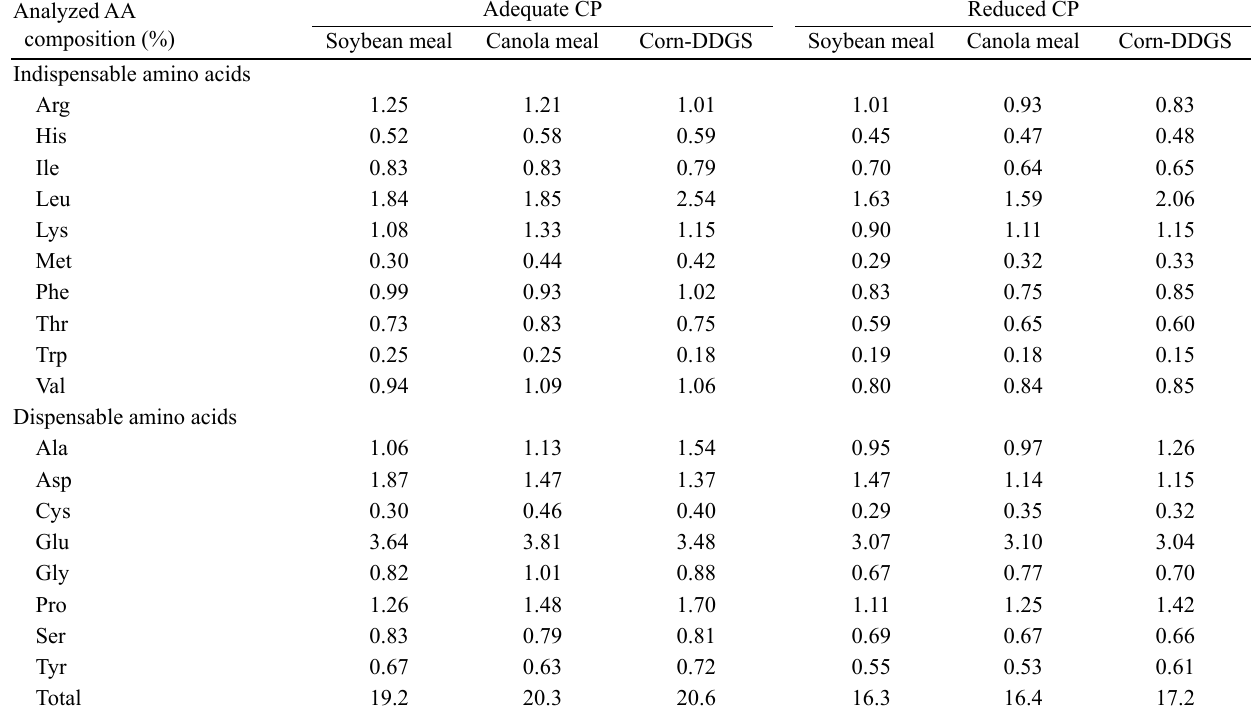
Table 2. Analyzed amino acids composition (dry matter basis) of diets to determine the effect of protein feedstuff and protein level on apparent or standardized ileal digestibility of amino acids in growing pigs Analyzed AA composition